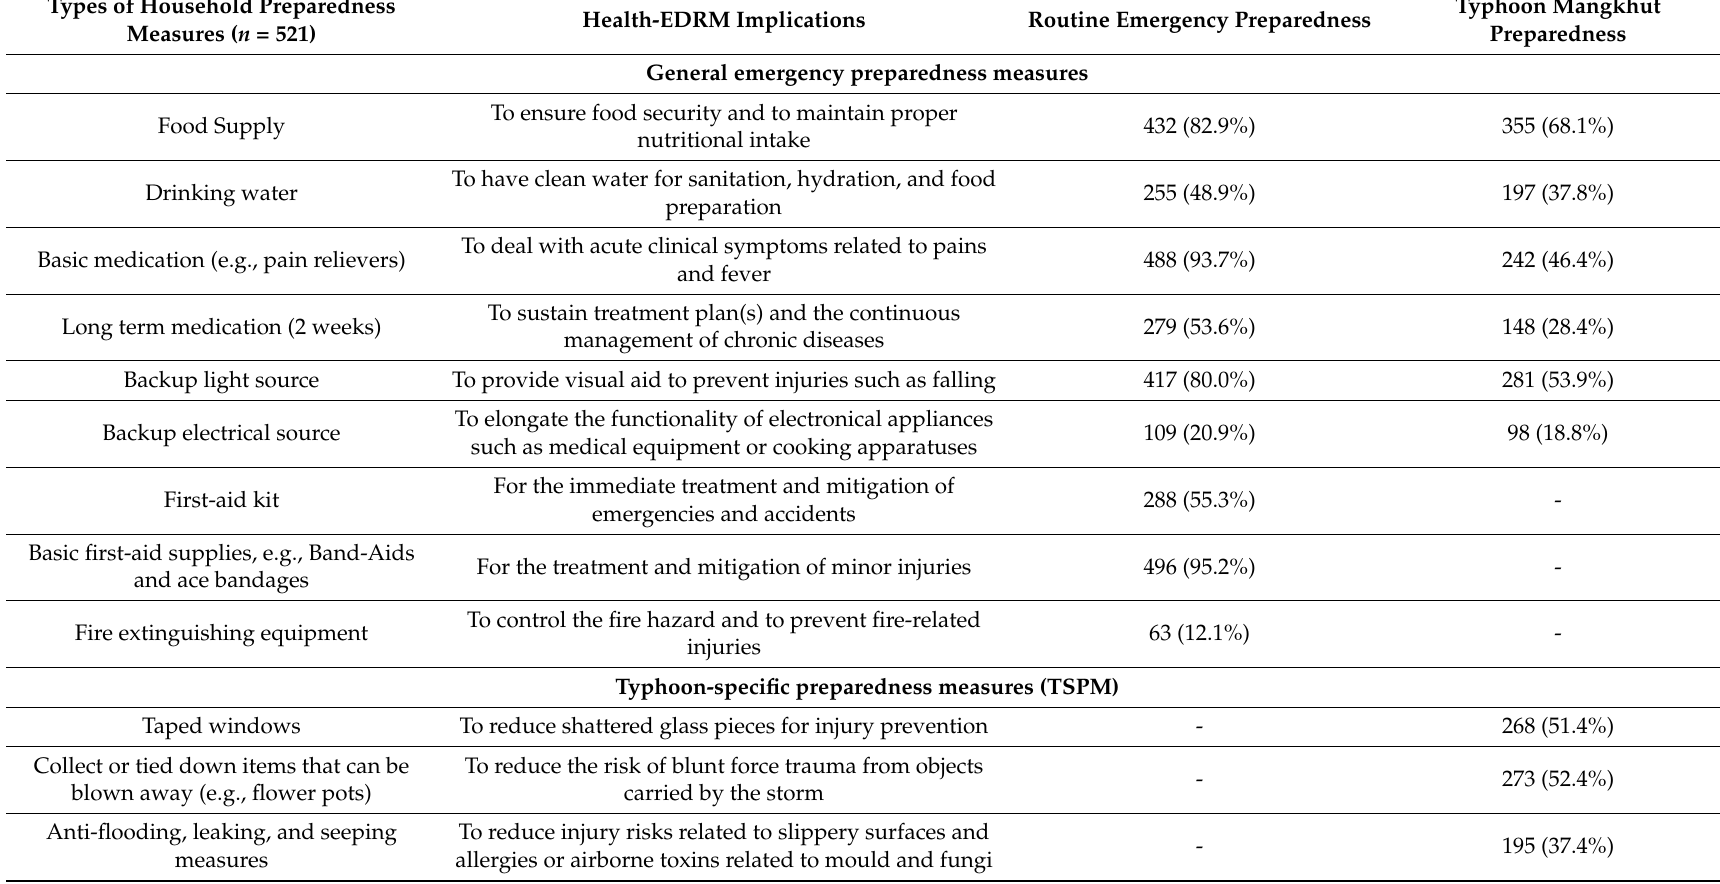
Table 1. The uptake rate of preparedness activities applied on usual days and for Typhoon